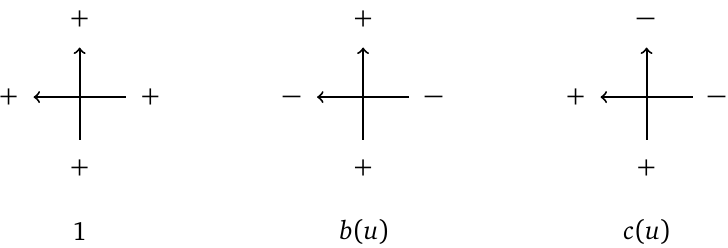
Figure 1: The vertex weights of the six vertex model. The functions b ( u ) and c ( u ) are given by (3.5) and (3.6), respectively. The R -matrix acts from bottom to top and right to